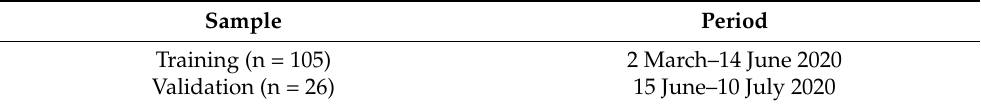
Table 2. Period for developing the FPA and